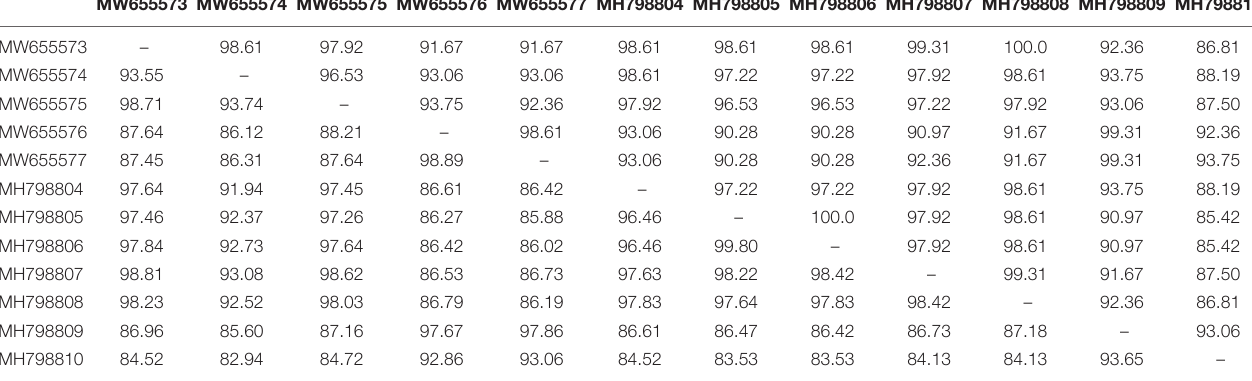
Nucleotide sequences are below the diagonal, while amino acid sequences are above the